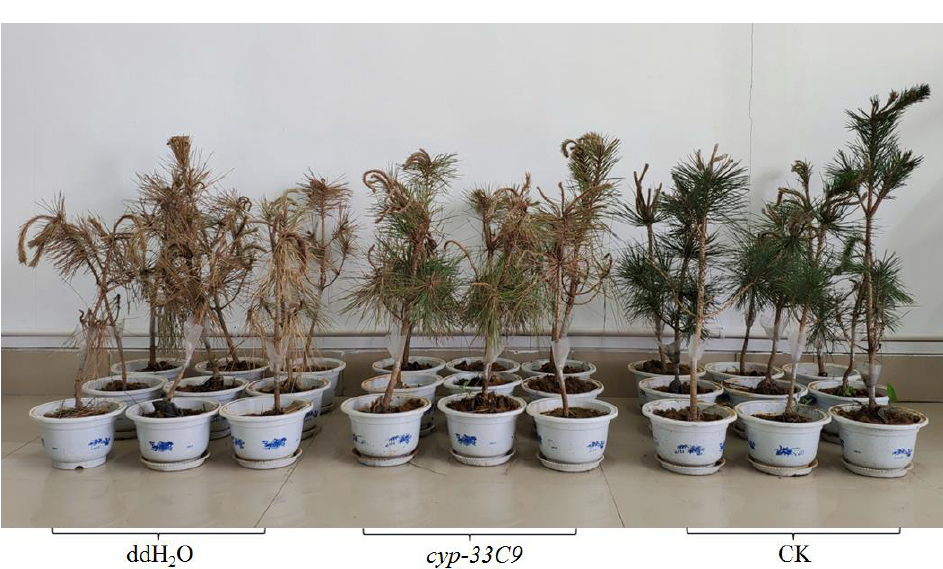
Figure 6. Wilting symptoms of P. thunbergii seedlings at 25 d after inoculation with Bursaphelenchus xylophilus soaked in ddH 2 O (“ddH 2 O”) or cyp-33C9 dsRNA solution (“ cyp-33C9” ), respectively. Controls (“CK”) were represented by P. thunbergii seedlings inoculated with ddH 2 O alone (no nematodes).